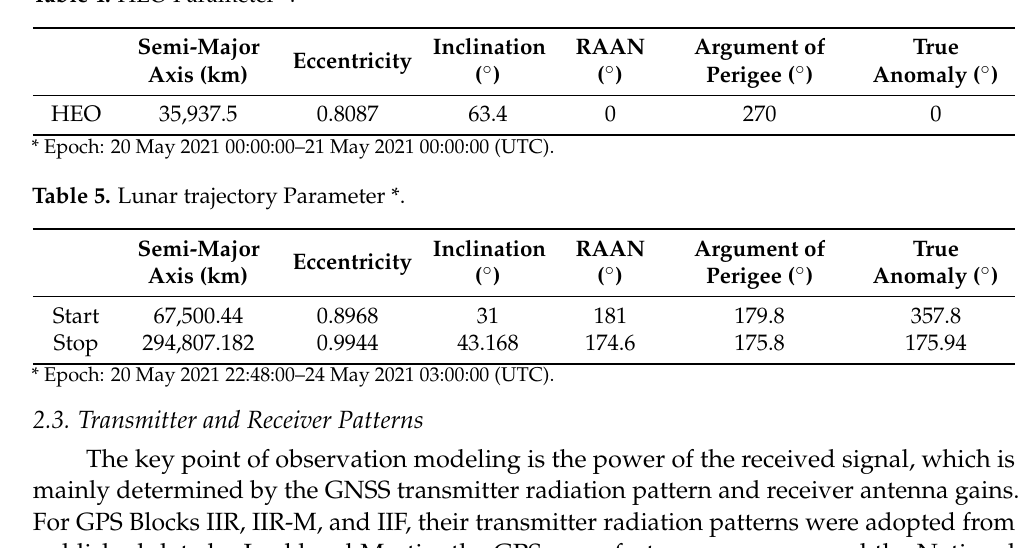
Table 4. HEO Parameter *.